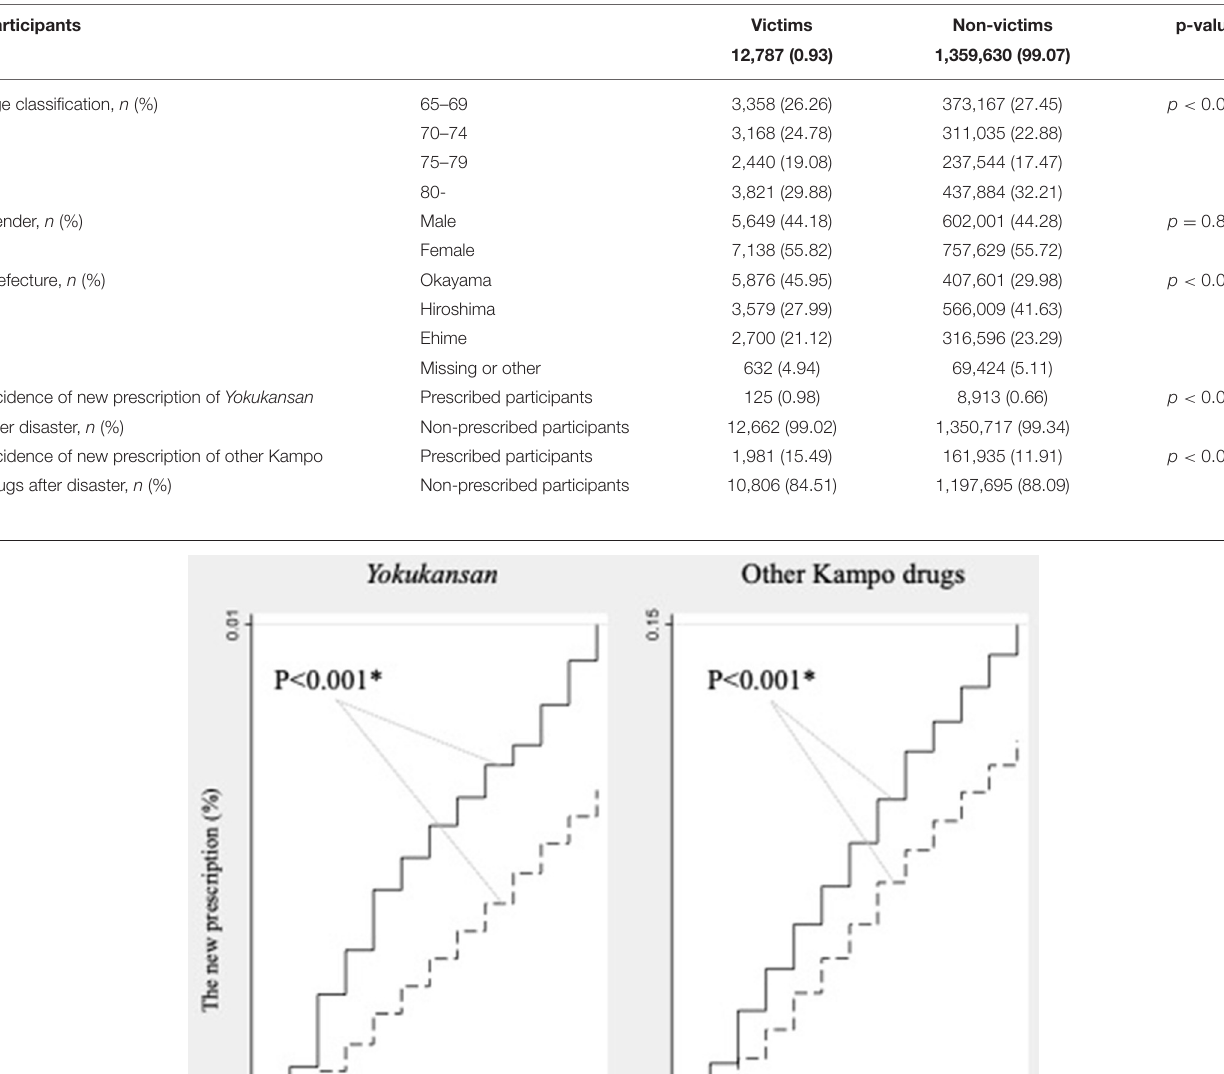
TABLE 1 | Basic characteristics of study subjects.